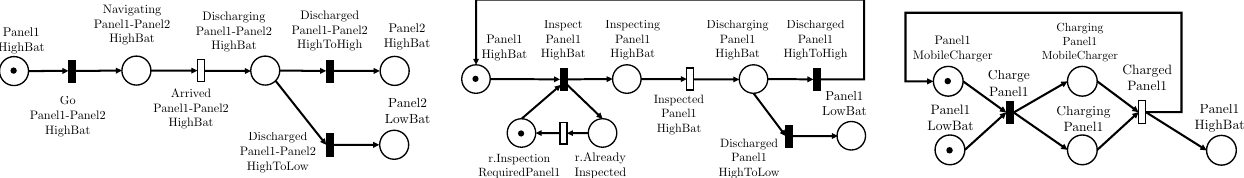
Figure 13. ( Left ) Navigation model with battery discharging transitions; ( Center ) Inspection model with battery discharging transitions and number of inspections counter; ( Right ) Recharging